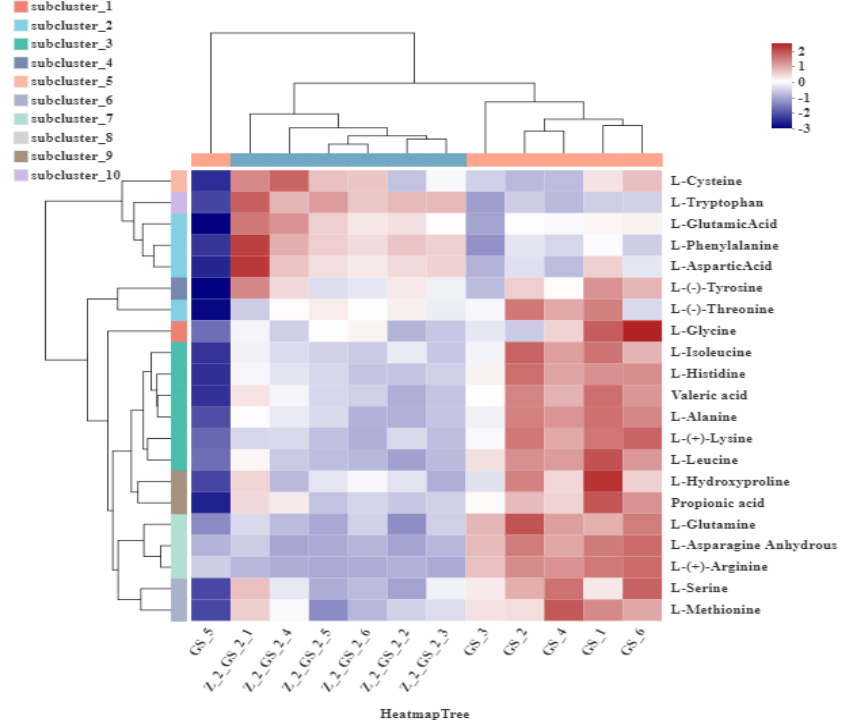
Figure 10. Hierarchical clustering heat map of targeted amino acid metabolites in the GS and Z-2-GS-2 groups. Note: the GS group represents Vigna angularis without the spraying of FSA and the Z-2-GS-2 group represents Vigna angularis under FSA stress.